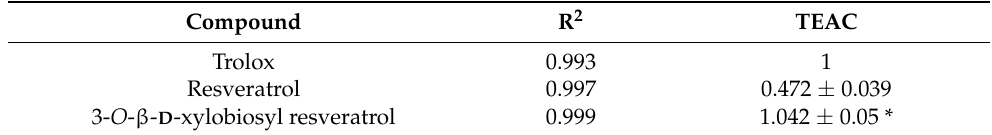
Table 1. Antioxidant activity of resveratrol and its major xylobioside using ABTS • + as substrate and Trolox as reference antioxidant